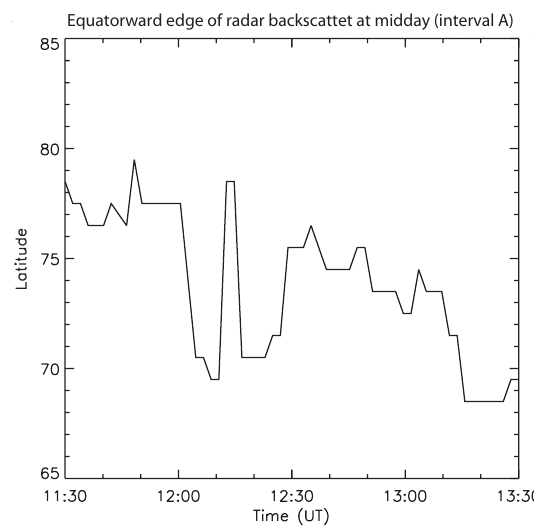
Fig. 11. The latitudinal position of the equatorward boundary of radar backscatter at local magnetic noon, observed between 11:30 and 13:30 UT during interval A.